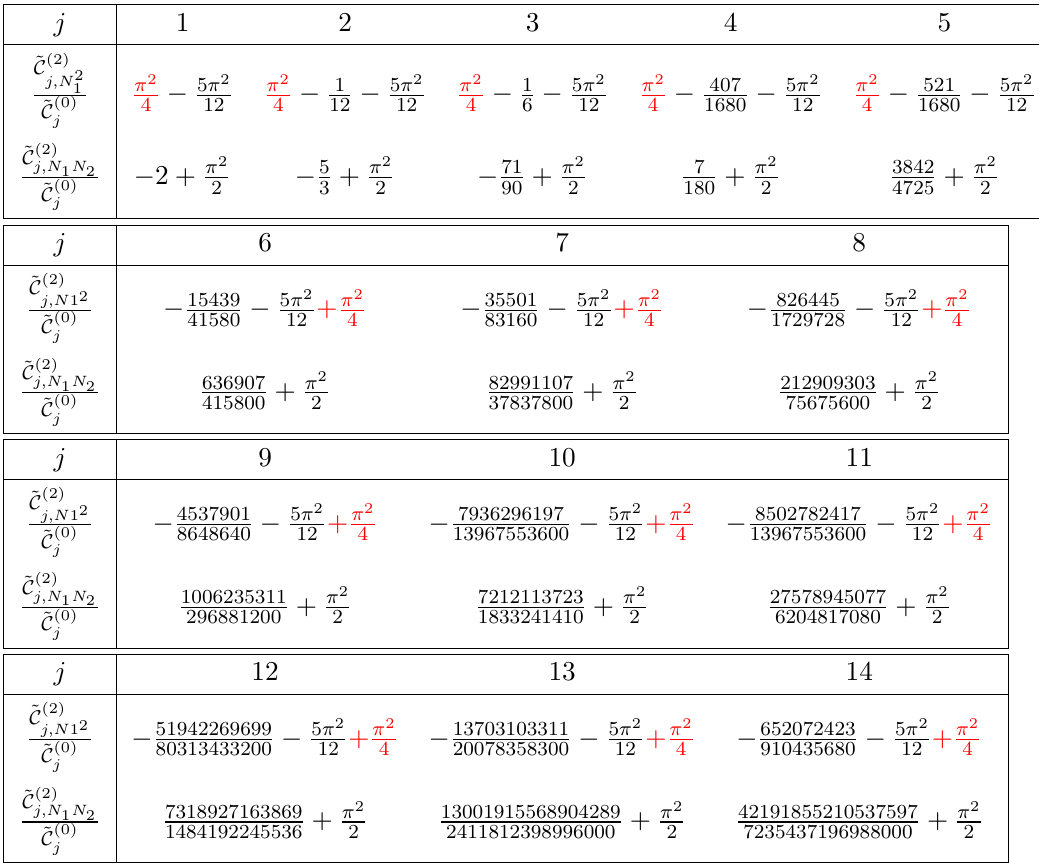
Table 2. Two-loop un-normalized structure constants of (5.5), derived from integrating over the insertion point of the operator with spin. The color components are separated for each spin and the ratio is taken by the tree-level contribution. As argued below, these results are missing a constant totally symmetric contribution that is neglected spuriously because of the extra integration. Then,